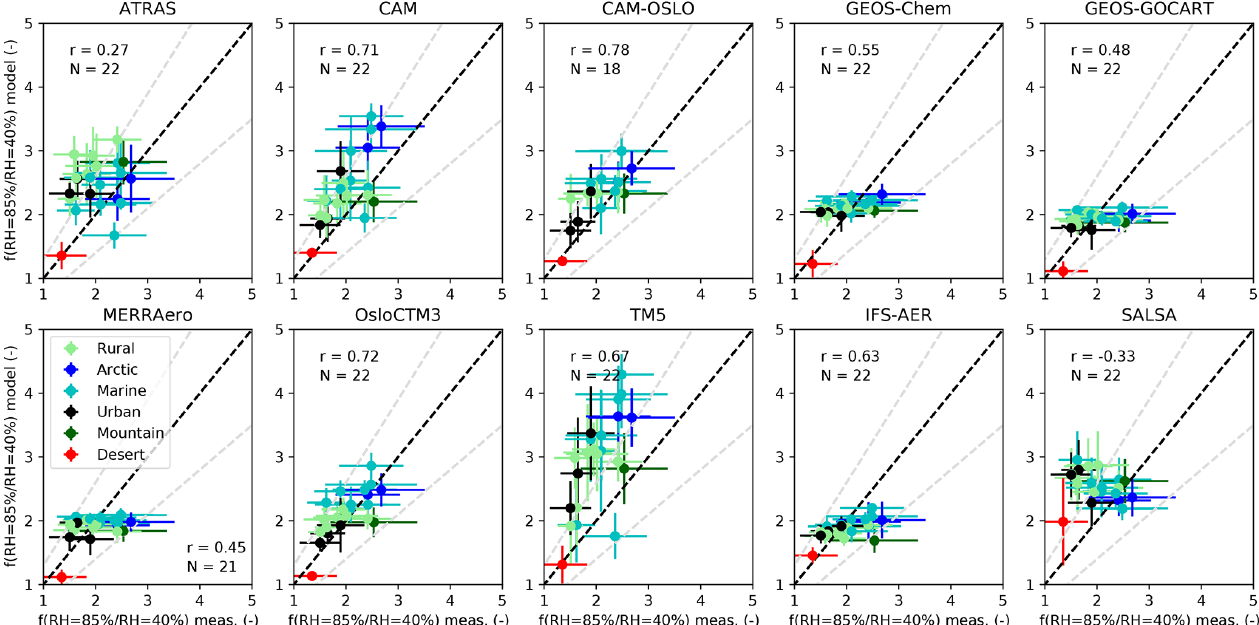
Figure 2. Simulated versus measured f (RH = 85% / RH ref = 40%) at λ = 550nm for each model color-coded by site type: blue for Arctic, cyan for marine, dark green for mountain, light green for rural, black for urban, and red for desert sites. The Pearson correlation coefficient ( r ) and the number of sites are indicated for each panel. The dashed black line shows the 1 : 1 line, and the gray dashed line shows the upper estimate of measurement